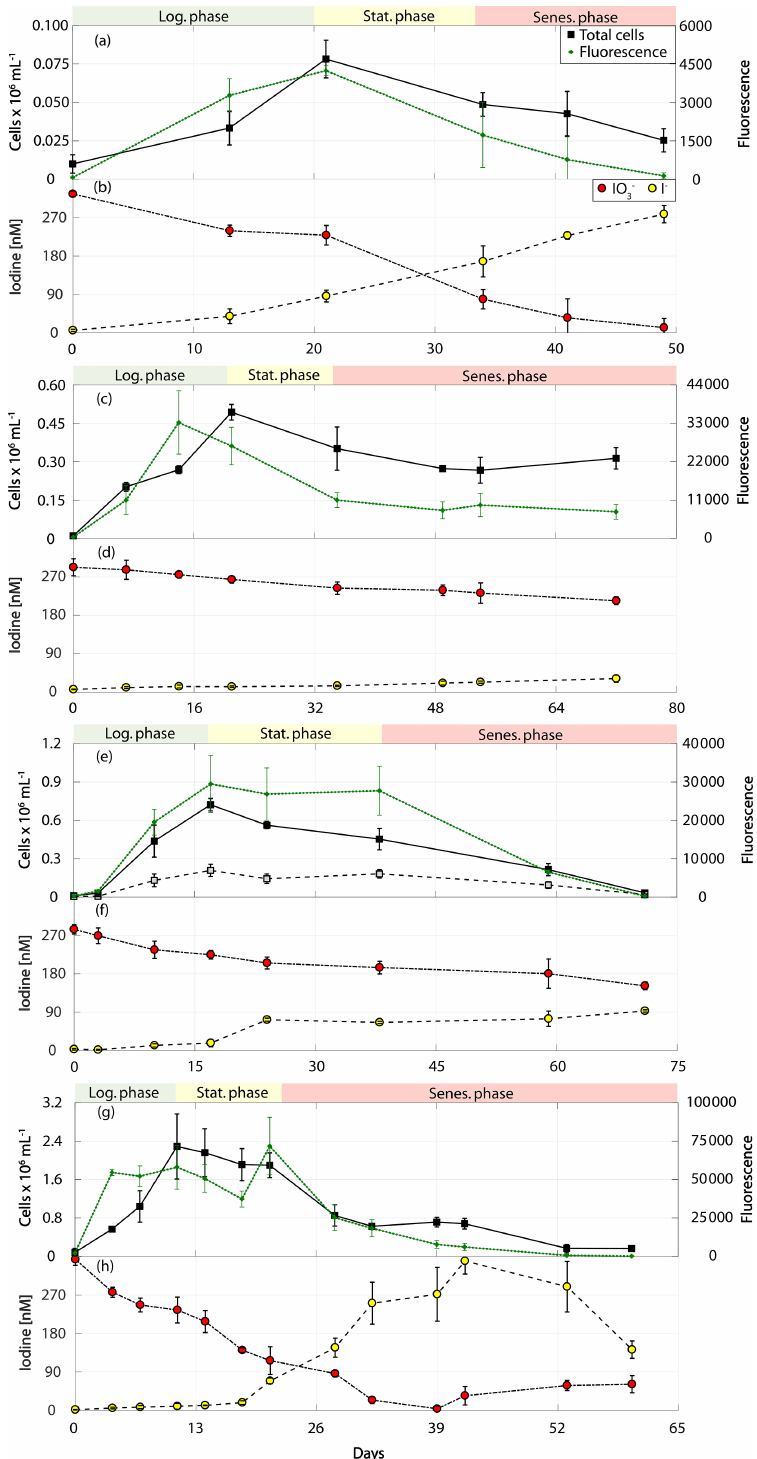
Figure 3. Total cell counts (black – total) and fluorescence readings (green) as well as inorganic iodine speciation (red – iodate, yellow – iodide) over the course of the growth curve experiments of calcifying prymnesiophytes for Calcidiscus leptoporus (RCC 1164) in (a) and (b) , Emiliania huxleyi (RCC 1210) in (c) and (d) , Gephyrocapsa oceanica (RCC 1318) in (e) and (f) , and Emiliania huxleyi (RCC 4560) in (g) and (h) . The colour-shaded bars on top of each graph indicate where the logarithmic phase (green), the stationary phase (yellow) and the senescent phase (red) began and ended based on total cell counts. Values depicted are means from culture replicates, with error bars indicating the standard deviations of these